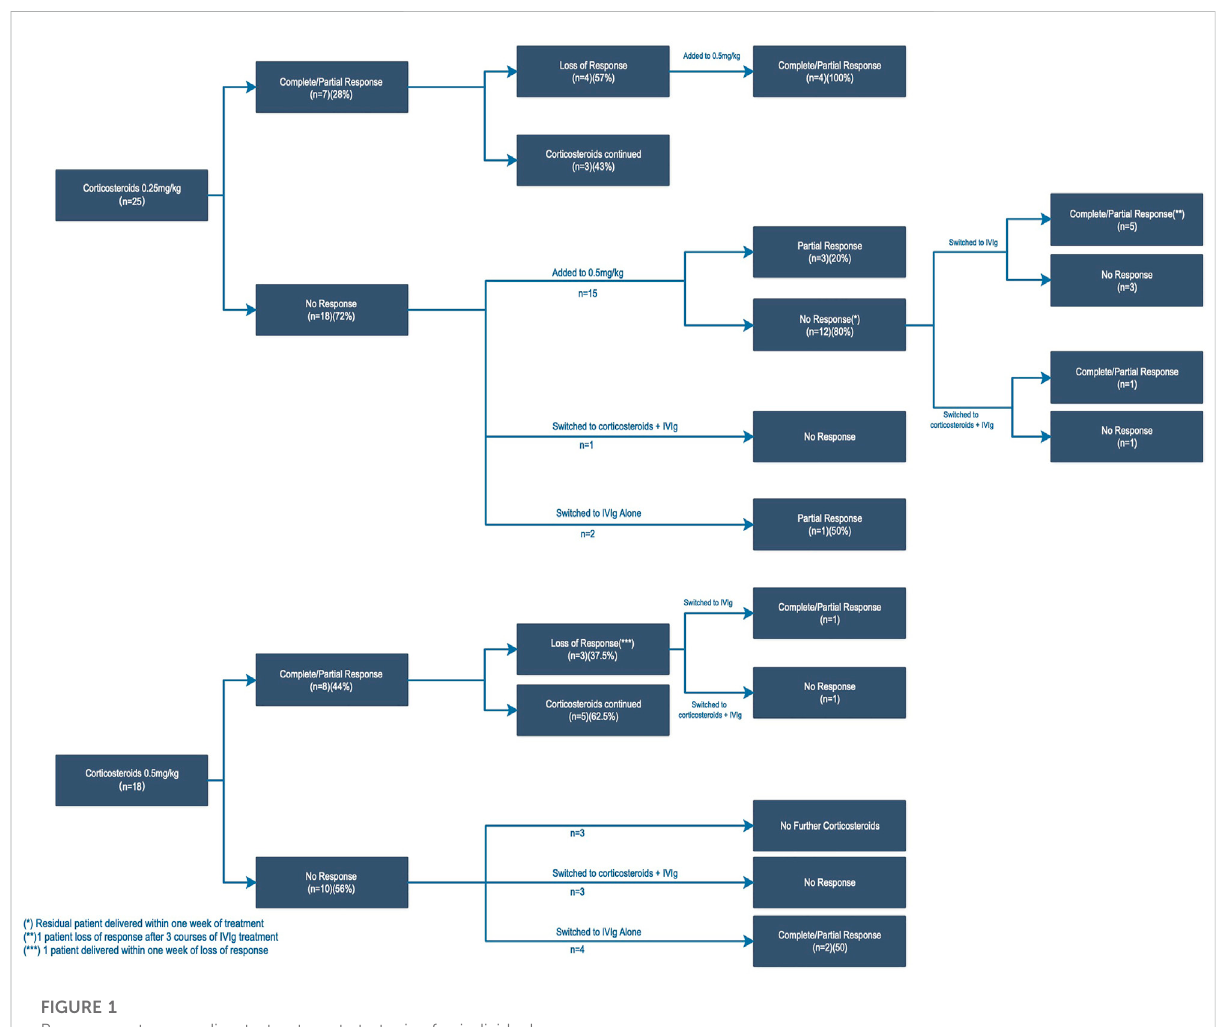
FIGURE 1 Response rate according to treatment strategies for individuals.